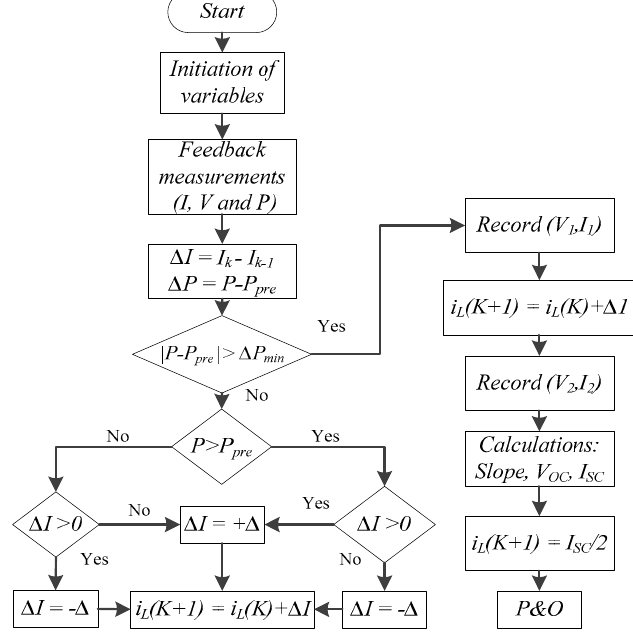
Figure 4. Proposed MPPT algorithm flow chart.